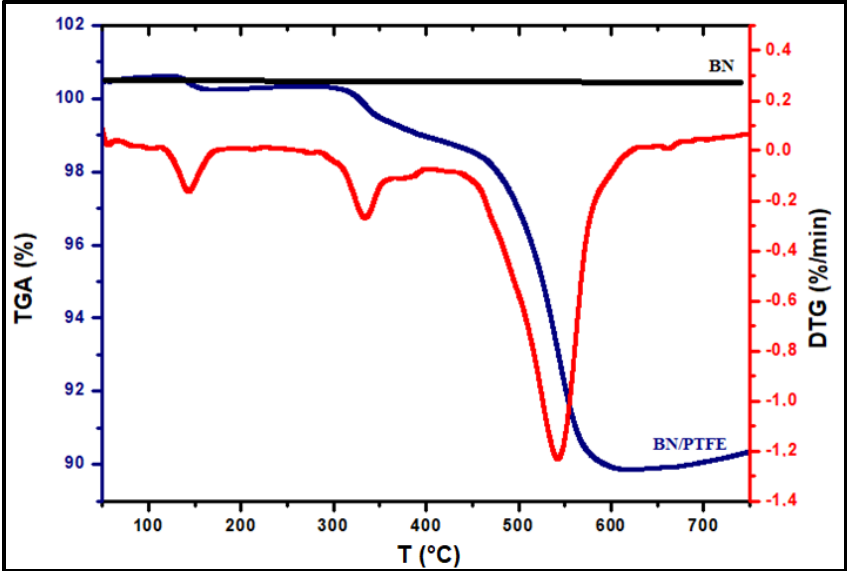
Figure 5. TGA analysis of Boron Nitride (BN) and BN/PTFE membrane.